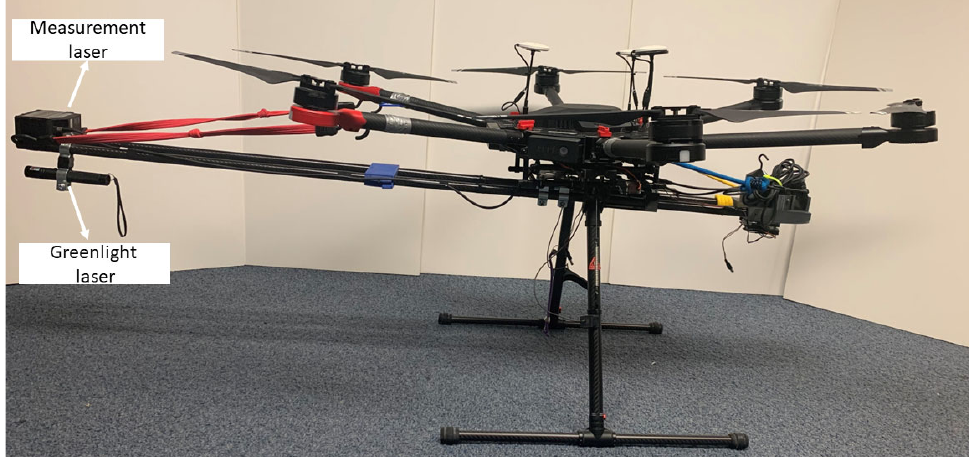
Figure 1. portable greenlight laser added in the UAS, next to the displacement measuring laser. Figure 1. Portable greenlight laser added in the UAS, next to the displacement measuring